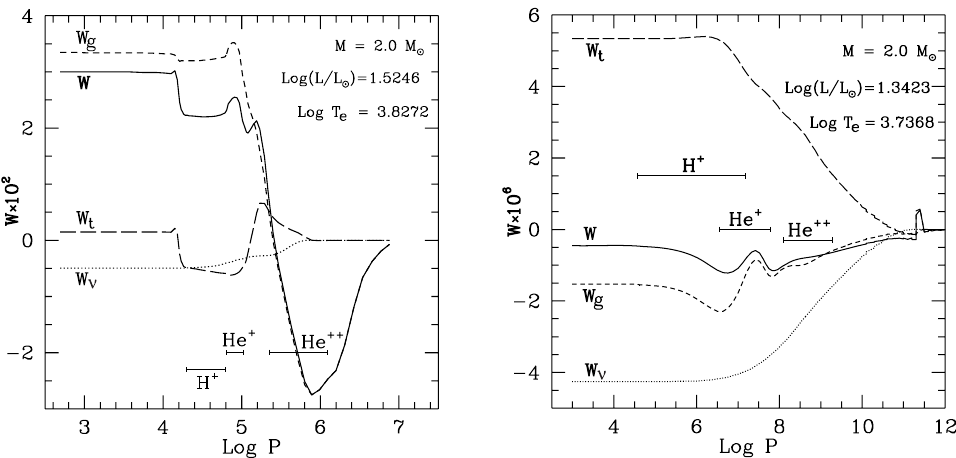
Figure 7: Accumulated work integral 𝑊 as a function of the depth co-ordinate log( 𝑝 ). Results are shown for the 𝑛 = 1 radial mode of a Delta Scuti star located inside the instability strip (left panel) and outside the red edge of the instability strip (right panel). The stability calculations include viscous dissipation by the small-scale turbulence (Xiong, 1989, see Eq. (138)). Contributions to 𝑊 (solid curve) arising from the gas pressure perturbations, 𝑊 g (dashed curve), the turbulent pressure perturbations, 𝑊 t (long-dashed curve), and from the turbulent viscosity, 𝑊 𝜈 (dotted curve), are illustrated ( 𝑊 = 𝑊 g + 𝑊 t + 𝑊 𝜈 ). The ionization zones of H and He are indicated. Images adapted from Xiong and Deng